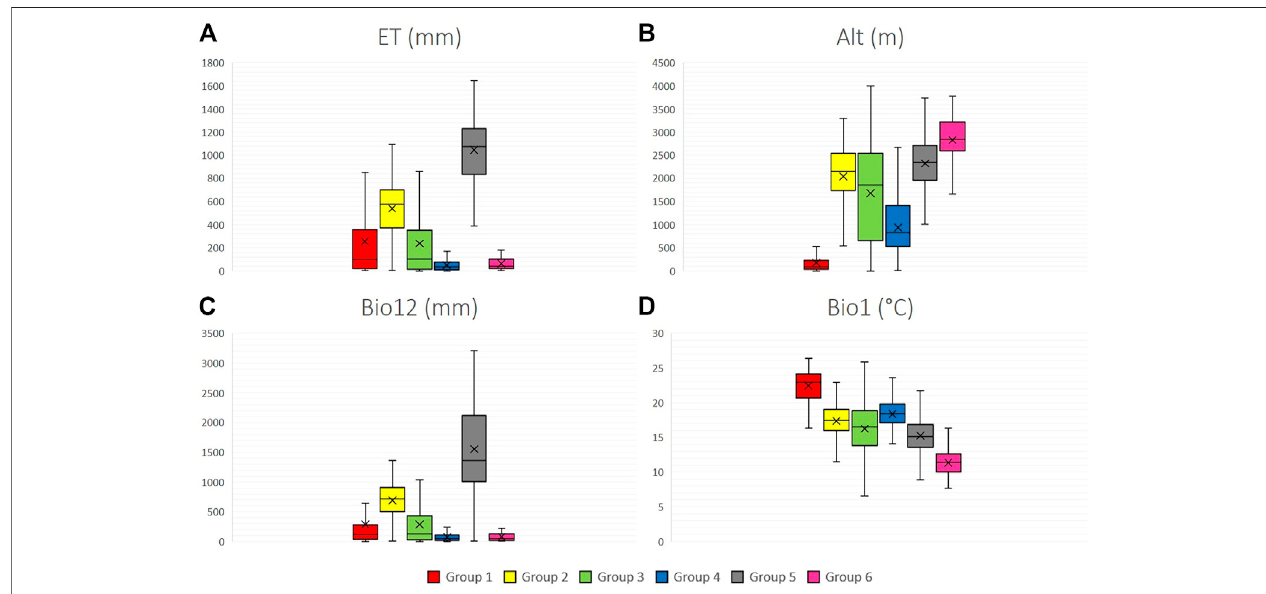
FIGURE 4 | Climate variables boxplots for six groups of 12 wild tomato species and 4 closely related species. (A) ET (annual evapotranspiration), (B) Alt (altitude), (C) Bio12(annualprecipitation), (D) Bio1(meanannualtemperature).Group1:SectionLycopersicon: “ Lycopersicongroup ” ( S.pimpinellifolium , S.cheesmaniae ,and S. galapagense ), Group 2: “ Arcanum group ” ( S. arcanum , S. chmielewskii , and S. neorickii ), Group 3: “ Eriopersicon group ” ( S. habrochaites , S. huaylasense , S. corneliomulleri , S. peruvianum ,and S.chilense ),Group 4: “ Neolycopersicon group ” ( S. pennellii );outgroup close related species insection Juglandifolia Group fi ve ( S. juglandifolium and S. ochranthum ) and Group six: Section Lycopersicoides ( S. lycopersicoides and S. sitiens ).